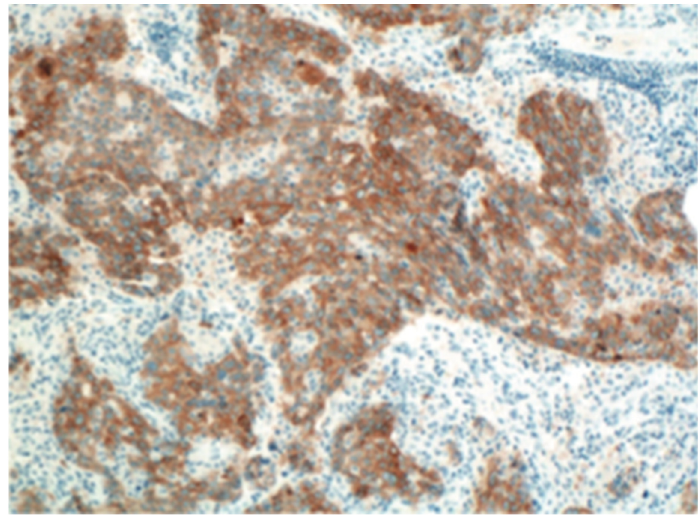
Figure 2. Immuno ‐ histochemistry (IHC); From Roche Ventana. Figure 2. Immuno-histochemistry (IHC); From Roche Ventana.